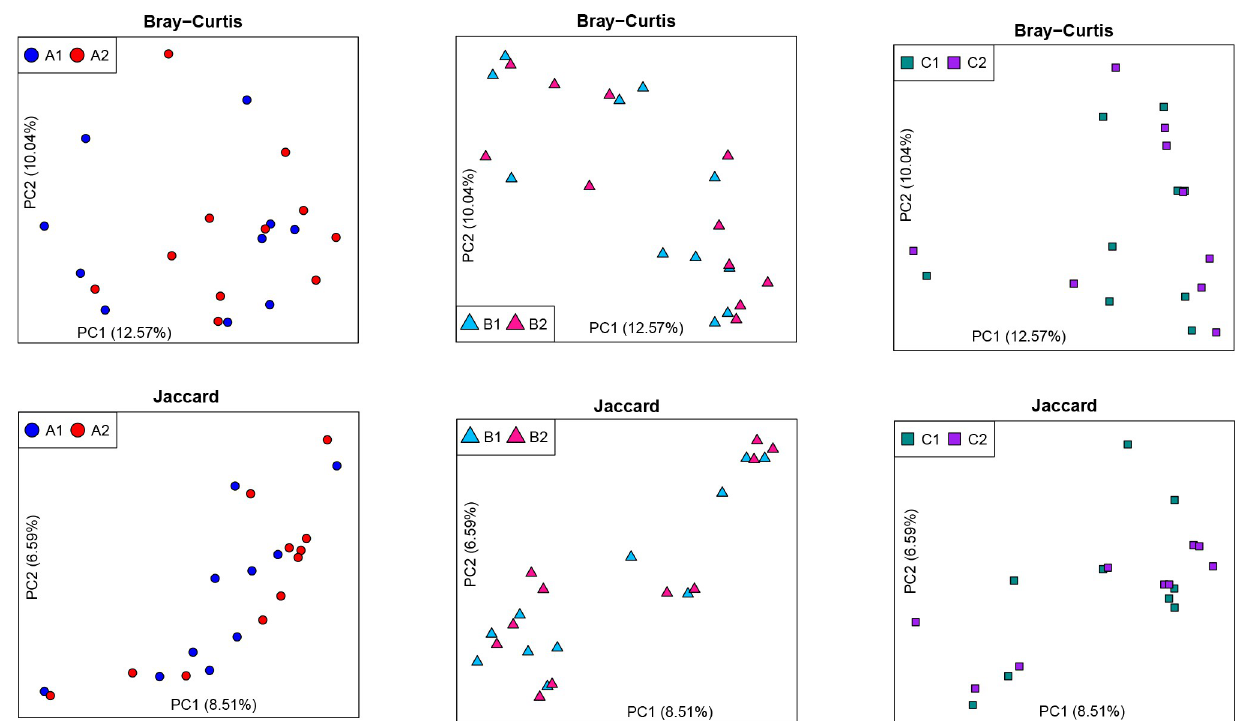
Fig 5. Microbial β -diversity expressed as Bray-Curtis and Jaccard distances. PCoA plots of Bray-Curtis and Jaccard distances are shown for each treatment. Week 0 and week 6 were compared in each. A1 = Group A (fermented vegetable) at week 0; A2 = Group A (fermented vegetable) at week 6; B1 = Group B (pickled vegetable) at week 0; B2 = Group B (pickled vegetable) at week 6; C1 = Group C (control) at week 0; C2 = Group C (control) at week 6.